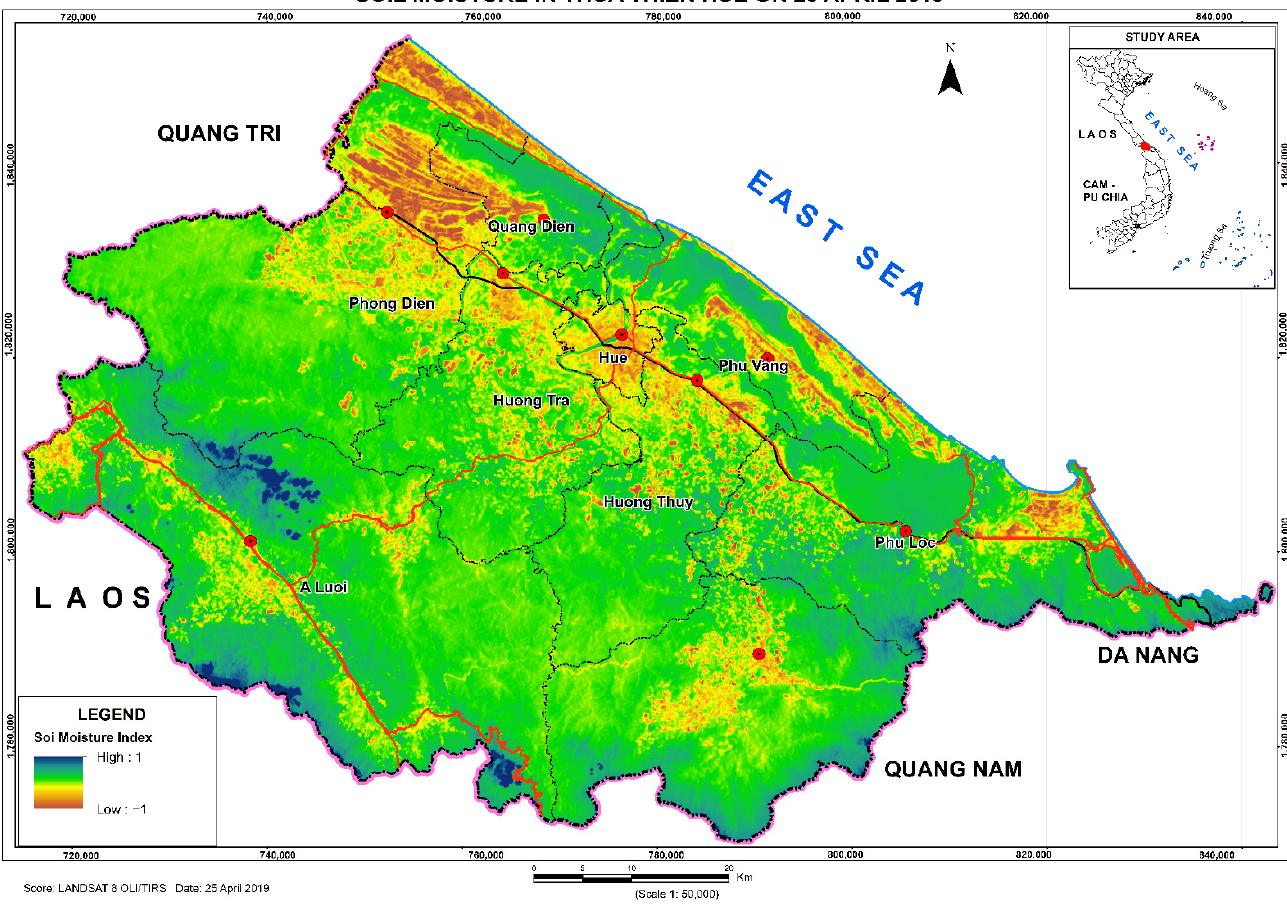
Table 7. Assessment Accuracy.